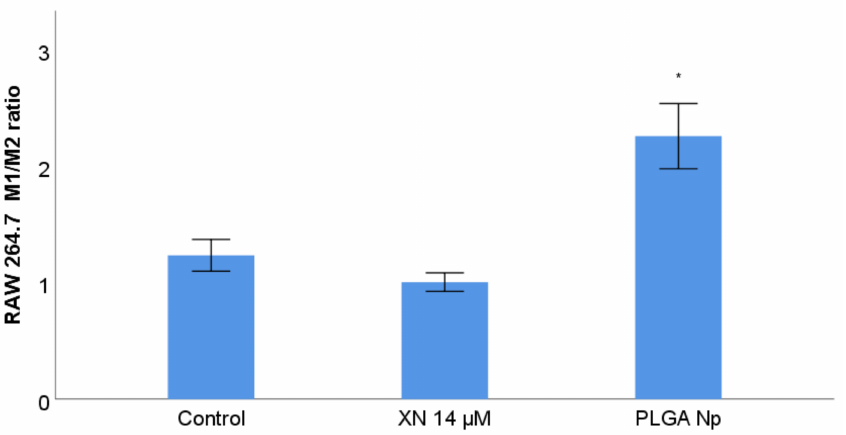
Figure 7. RAW 264.7 phenotype membrane markers study with previous stimulation with XN solubilized form and PLGA nanoparticles. The control refers to RAW 264.7 incubated with DMEM. “XN”, “Np” and “PLGA” stands for XN, nanoparticles and poly-lactic-co-glycolic acid, respectively. M1 represents an anti-tumour phenotype and M2 a pro-tumour phenotype. M1/M2 ratio values are expressed as mean ± S.E.M.( n = 6 for each treatment assay).* Statistically different at a level of p < 0.050 in comparison with the